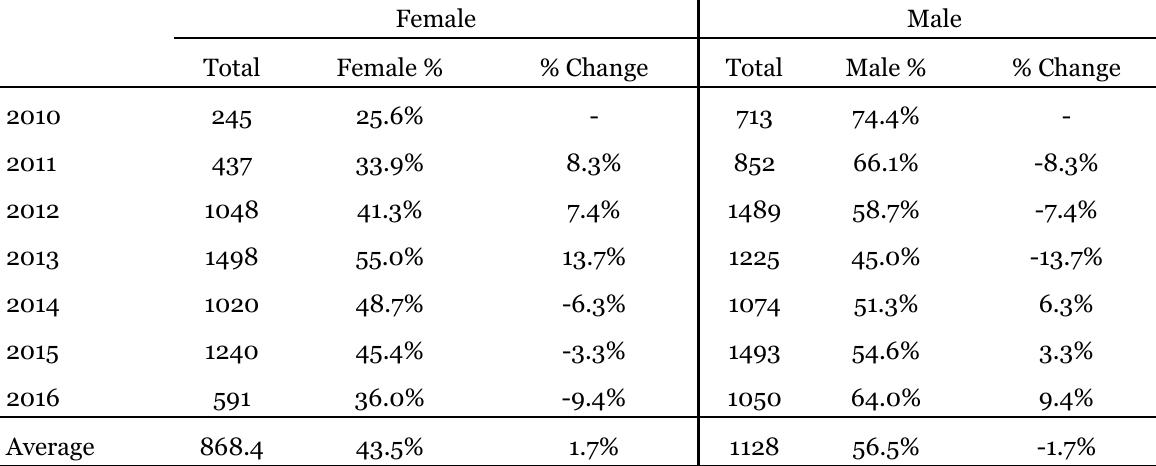
“Open” Tweets by Sampled User Gender Each Year